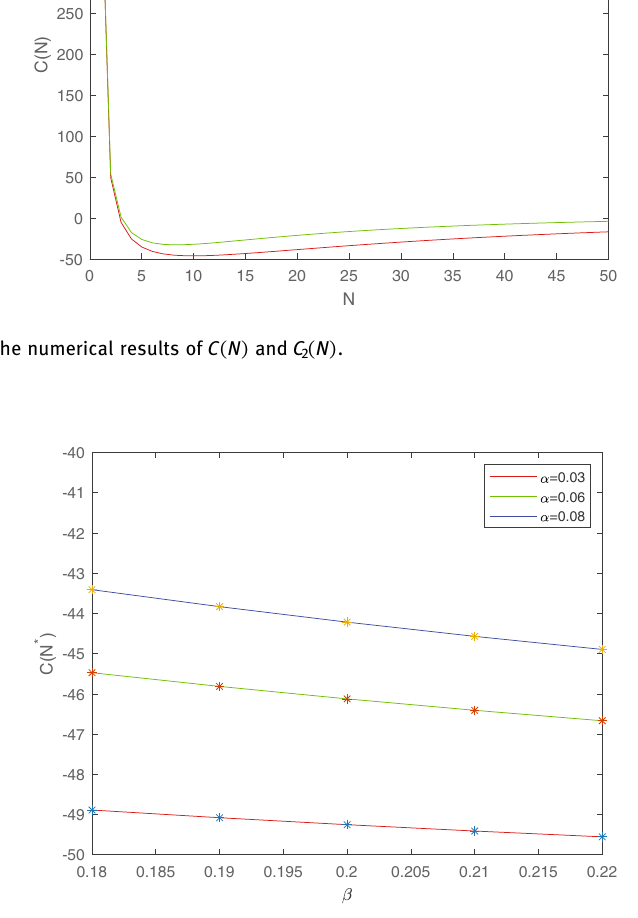
Figure 3: The e ff ect of parameter ( ) α β , ∗ N and ( ) ∗ C N .